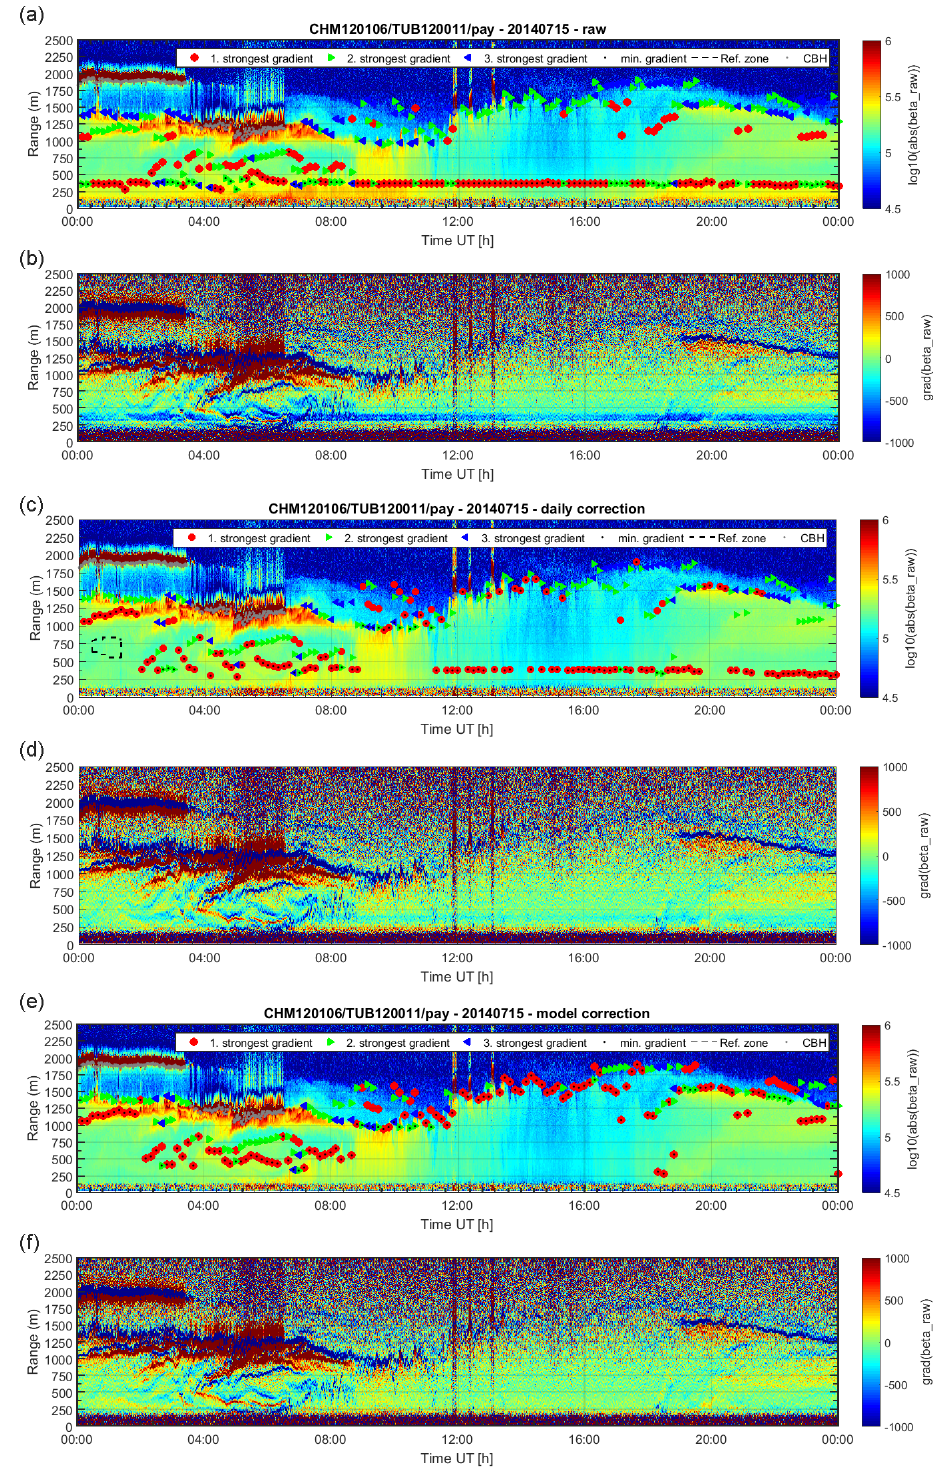
Figure 8. Times series PBL retrievals for 15 July 2014. The red markers show the strongest gradient detected before correction (a, b) , with daily correction (c, d) and with temperature model correction (e, f)